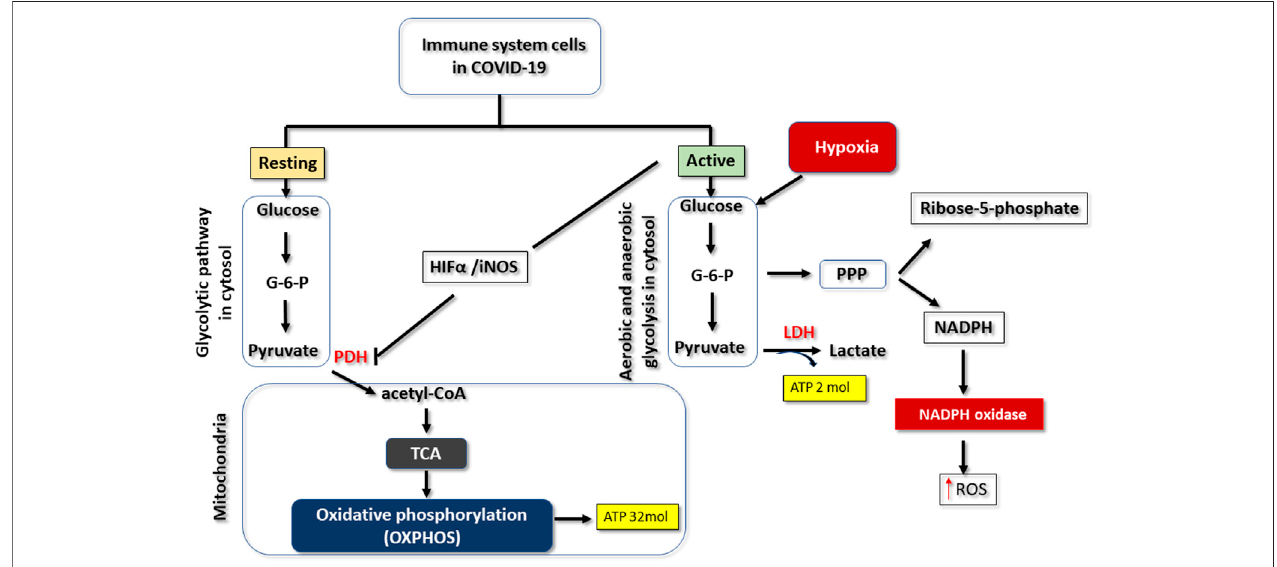
FIGURE 1 | Changes that can occur in the glycolytic pathway in COVID-19. When immune cells are resting, glucose is metabolised via the glycolytic pathway, yielding pyruvate as a product. This substrate is subsequently used in the tricarboxylic acid cycle (TCA) to form intermediates that will be processed by oxidative phosphorylation to produce 32 molecules of ATP, for each molecule of glucose. When immune cells are activated or hypoxic, glucose metabolism is reprogrammed. There is an increase in the type 1 alpha hypoxia-inducing factor (HIFa), which inhibits pyruvate dehydrogenase enzyme complex (PDH). Pyruvate is thus transformed into lactate by the action of lactate dehydrogenase (LDH). But this mechanism motivates the capture of more glucose for the synthesis of further ATP molecules. There is also activation of the pentose phosphate (PPP) pathway that produces ribose and NADPH. The latter can be used by immune cells through the actions of NADPH oxidase to produce reactive oxygen species